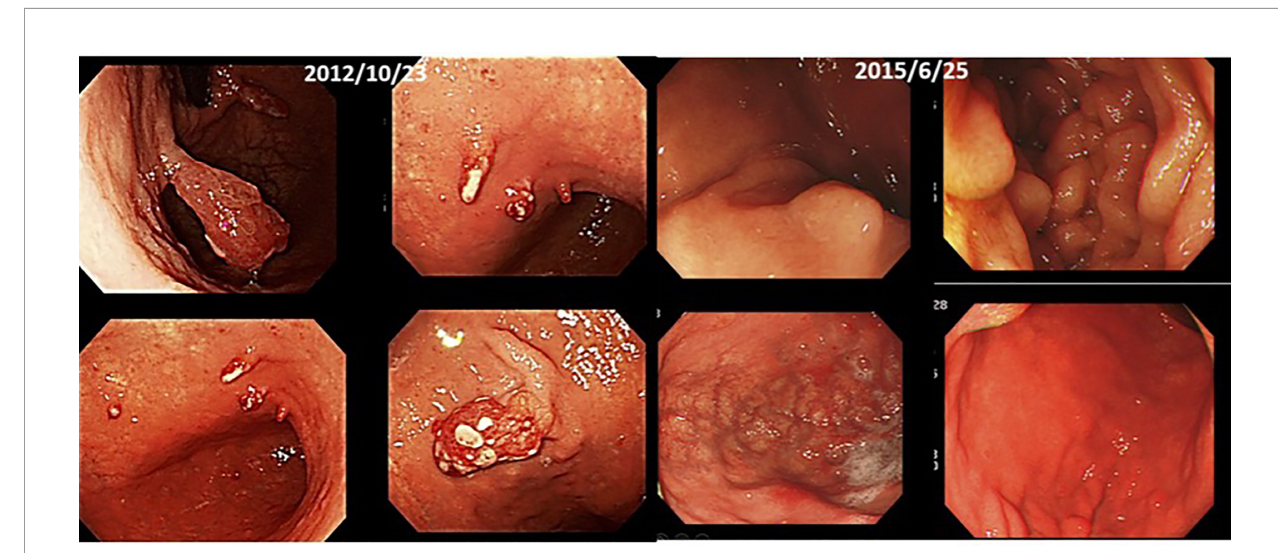
FIGURE 9 | An upper gastrointestinal endoscopy showed that all tumors had